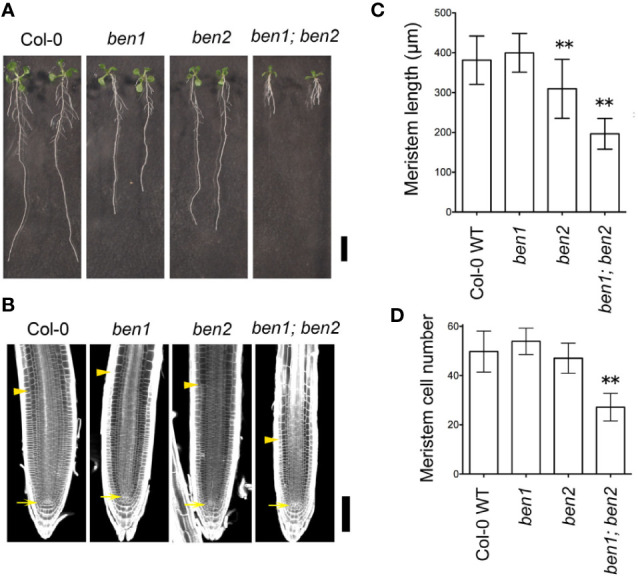
Phenotype of ben1; ben2 mutant roots. (A) Gross morphology of wildtype Col-0, ben1, ben2, and ben1; ben2 mutants at 10 days after germination (DAG). (B–D) Meristem size of primary roots in Col-0, ben1, ben2, and ben1; ben2 at 5 DAG. The arrows and arrowheads in (B) indicate the positions of the QC and the boundary between the meristematic zone and the elongation zone of root, respectively. Representative data from at least three independent biological replications are shown. Asterisks (**) in the graphs (C, D) represent significant difference (p-value ≤ 0.01 by Student's t-test). Error bars represent SD (n ≥ 15 for (C) and n ≥ 19 for (D)). Scale bars: 10 mm in (A); 100 µm in (B).